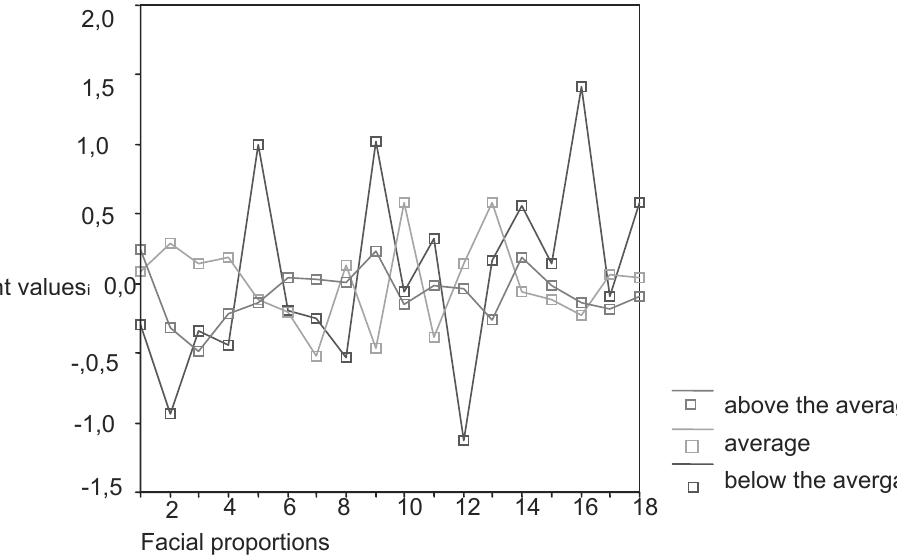
Fig. 3. Relation between facial metric parameters and desirable to marry – not desirable to